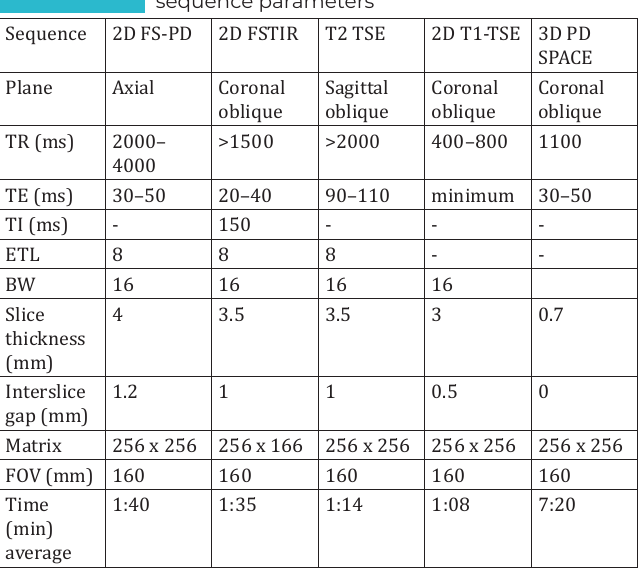
Shoulder magnetic resonance imaging sequence parameters